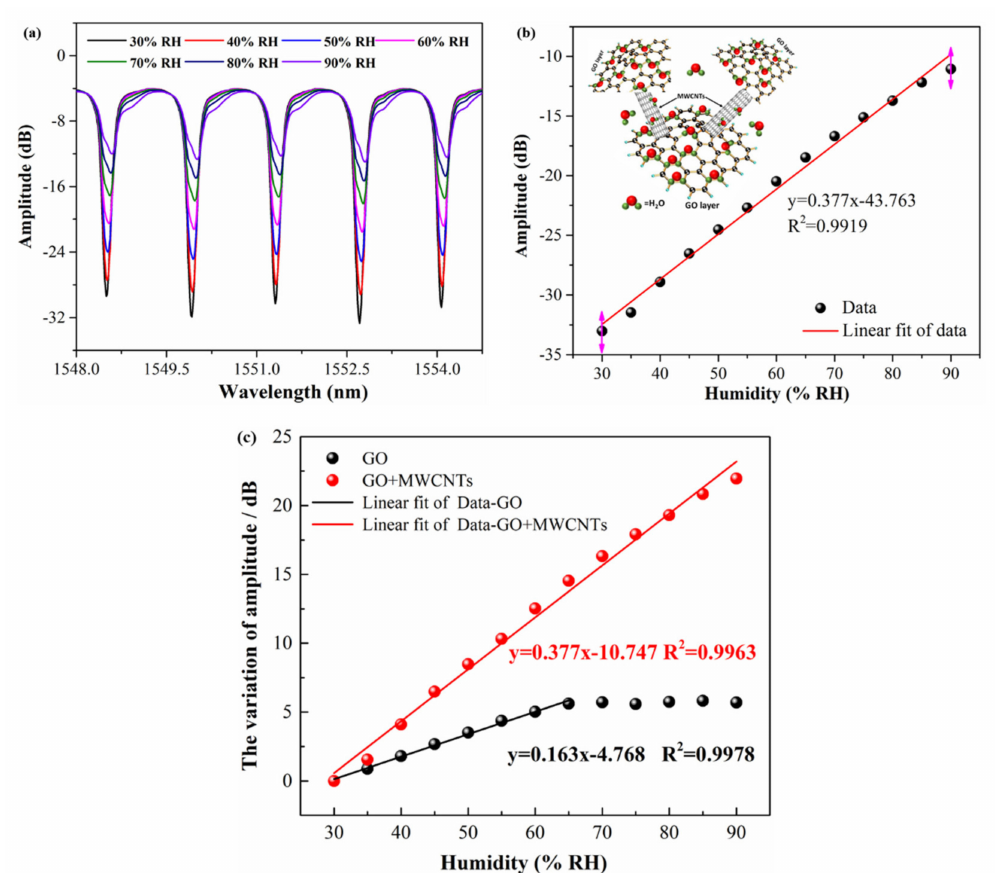
Figure 4. Humidity sensing performances. ( a ) Spectral response of TFBG coated with GO/MWCNTs film to different relative humidity. ( b ) Relative humidity sensitivity of TFBG coated with GO/MWCNTs film. ( c ) Relative humidity sensitivity comparison between TFBG coated with GO and GO/MWCNTs.